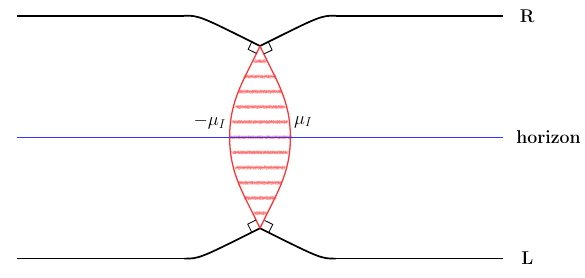
[ (cid:22) I ; (cid:22) I ]. 2 (cid:0) (cid:22) I , respectively. (cid:6) (and the corresponding I